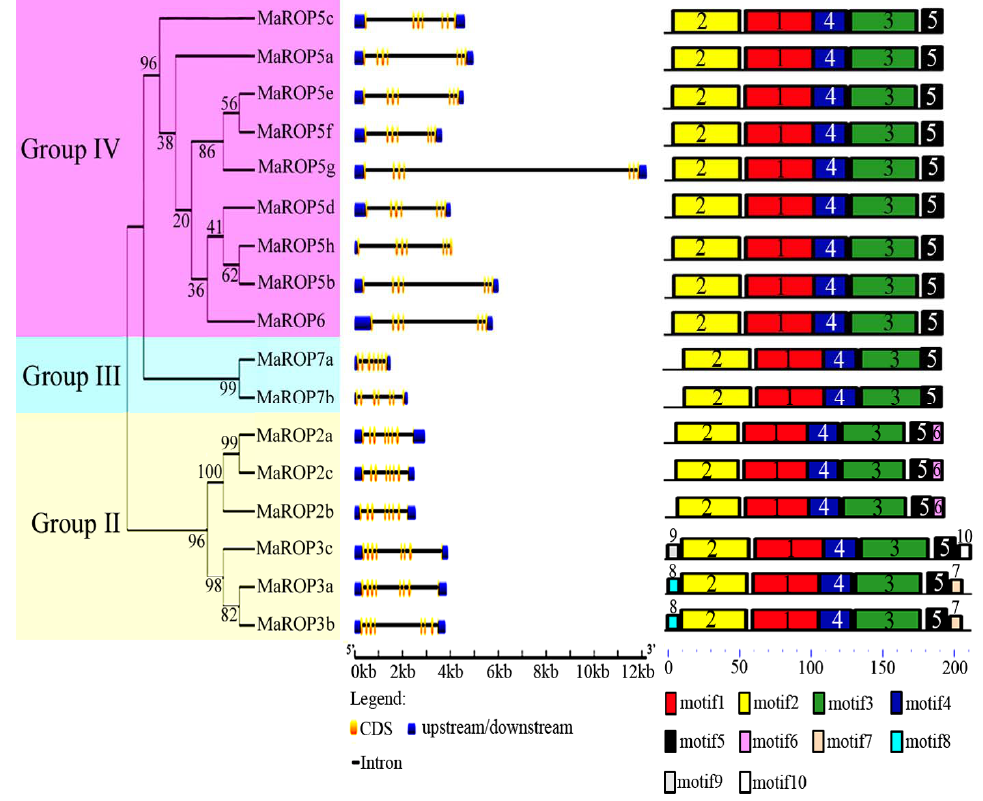
Figure 2. Phylogenetic, gene structure, and motif analyses of banana Musa acuminata ROP (MaROP) proteins. MaROPs were classified into Groups II–IV based on their phylogenetic relationships. Exon–intron structure analyses were performed with the Gene Structure Display Server (GSDS). Blue boxes indicate upstream/downstream; yellow boxes indicate exons; black lines indicate introns. All of the proteins were identified using the Multiple EM for Motif Elicitation (MEME) database, using the complete predicted amino acid sequences of each MaROP. Motifs 1–4 were annotated as a RhoGEF domain.